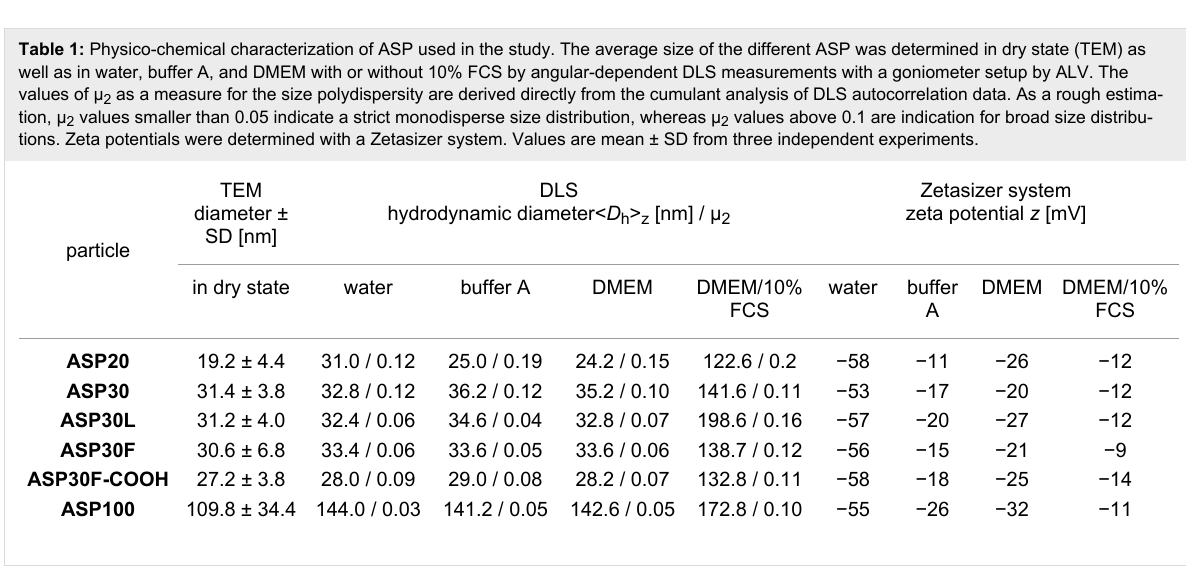
Figure 1: Transmission electron microscopy (TEM) images of representative ASP used in the study. Scale bar = 100 nm.